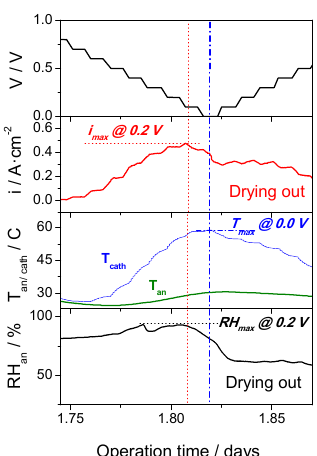
Figure 9. Operation parameters of the cell with a dry nitrogen stream to flush the external anode chamber with a flow rate of 1.67 mL · s − 1 .